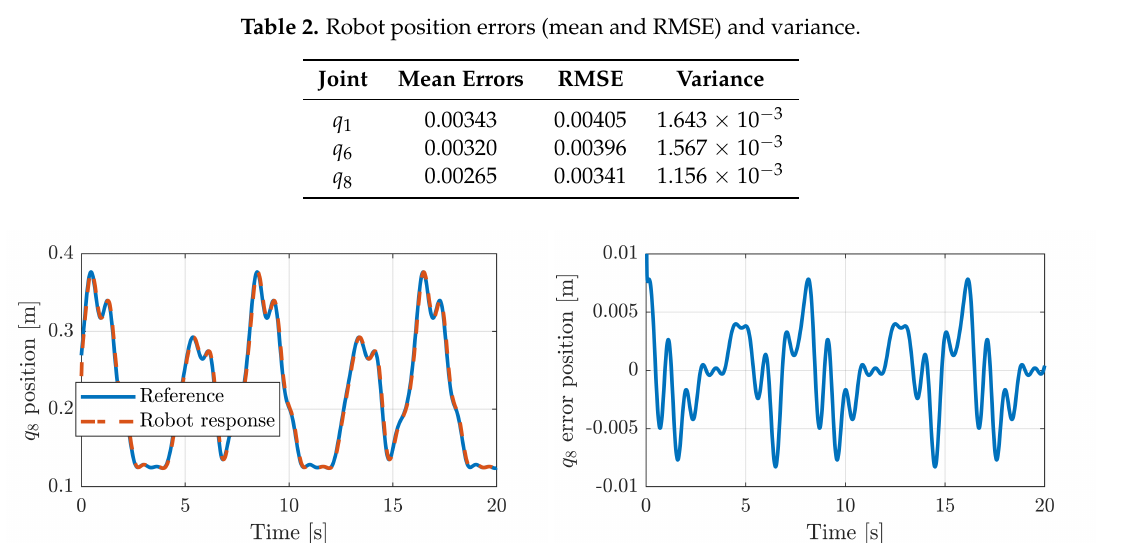
Figure 11. The response of the generalized coordinate q 8 in Simulink.